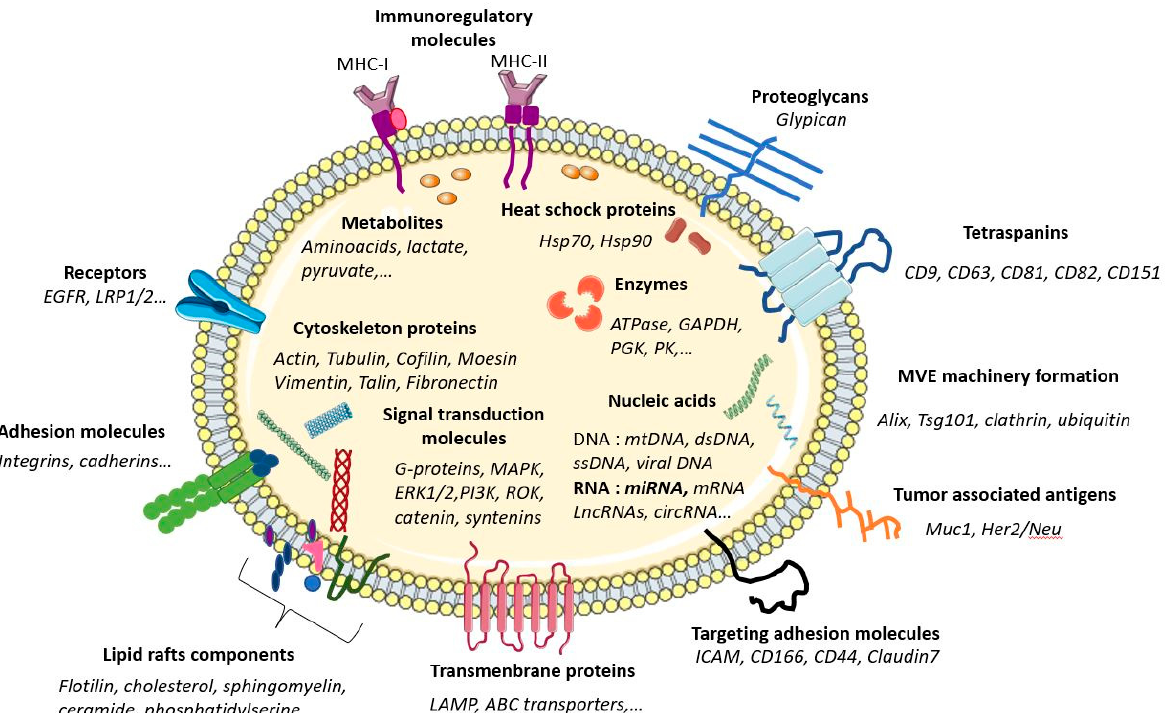
Figure 2. Exosome membrane molecules and their cargo content. Small extracellular vesicles (SEVs) are nano-sized membrane vesicles released by a variety of cell types and are thought to play important roles in intercellular communications. SEVs contain many kinds of proteins, either cytosolic or plasma membrane ones. Transporters, receptors, and signaling proteins, but also enzymes, can be evidenced. Metabolites are also present as well as nucleic acids. Genomic and mitochondrial DNAs and multiple RNAs (mRNAs, miRNA, lncRNA, circRNA, etc.) can be detected. Through the horizontal transfer of these bioactive molecules, SEVS are emerging as local and systemic cell-to-cell mediators of oncogenic information.